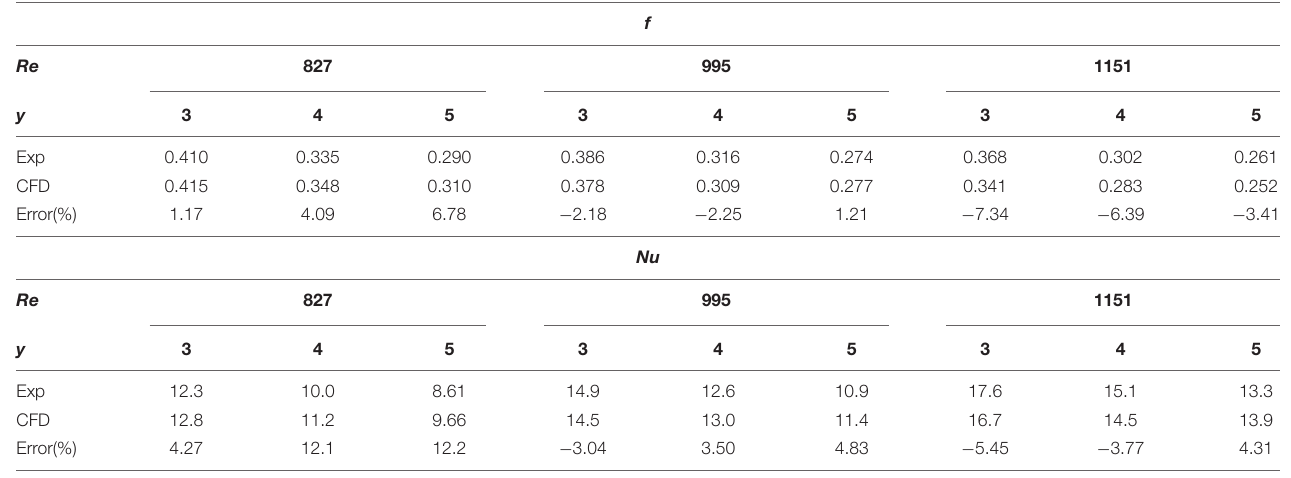
TABLE 1 | Comparison of the CFD results with experimental results (Wongcharee and Eiamsa-Ard, 2011).